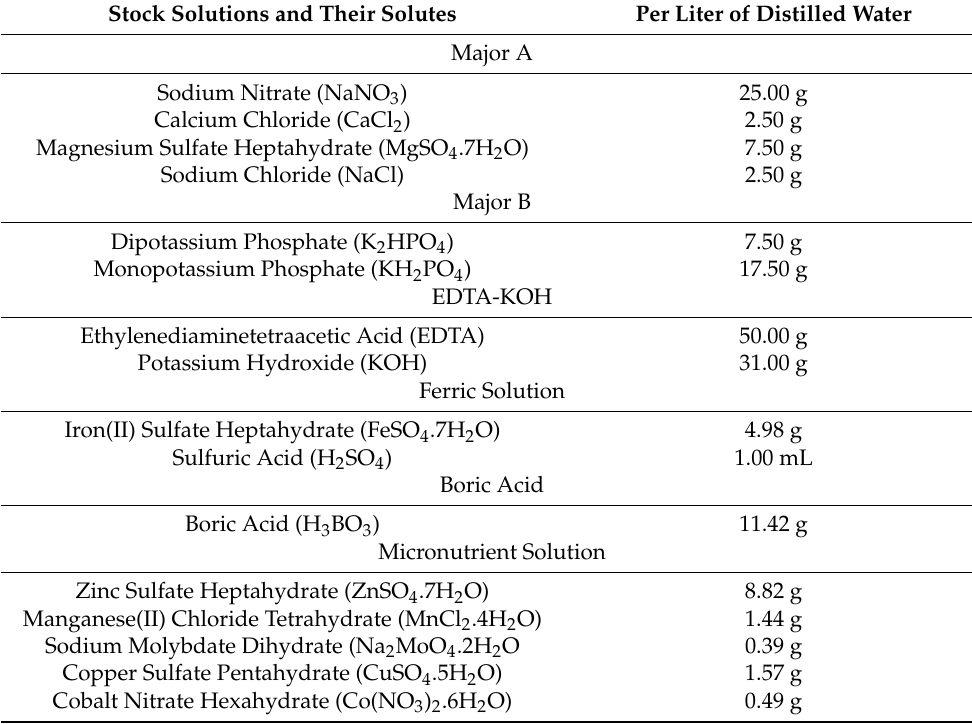
Table 1. Preparation of BBM